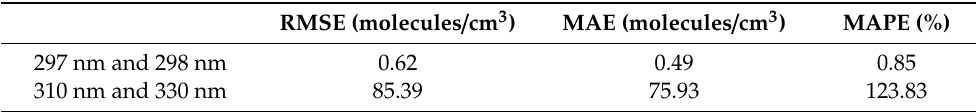
Figure 7. Variation of error with the wavelength interval. Table 2. Comparison of the detection error between the optimal detection wavelength positions (i.e., 297 nm and 298 nm) and the common volcanic detection wavelength positions (i.e., 310 nm and 330 nm).